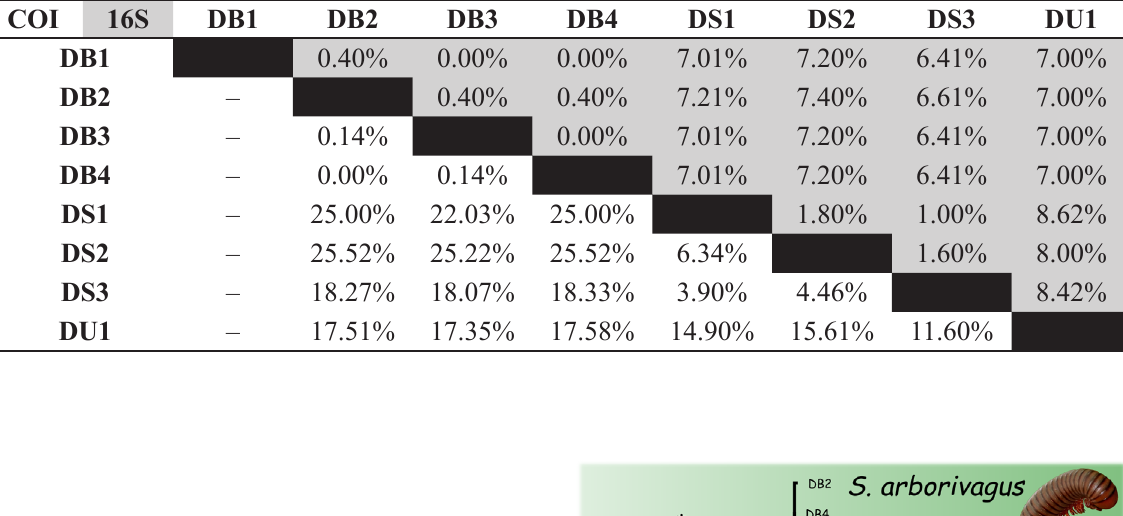
Table 2. Estimates of Evolutionary Divergence between Sequences. The number of base differences per site between sequences are shown. DB1–DB4 = Sechelleptus arborivagus sp. nov.; DS1–DS3 = Sechelleptus variabilis VandenSpiegel & Golovatch, 2007; DU1 = Sechelleptus sp. Molecular analyses were conducted in MEGA X (Kumar et al . 2018; Stecher et al . 2020).